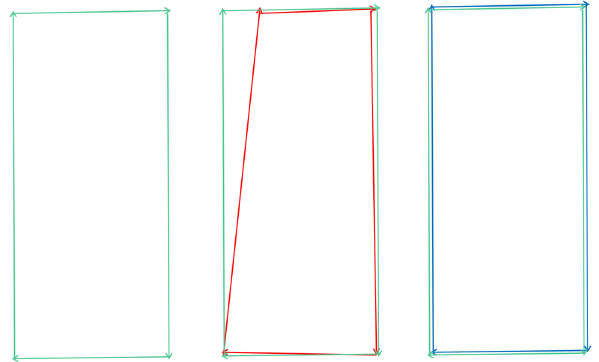
Fig. 1 The green line is the true trajectory. The red line is the drift- ing trajectory. The blue line indicates that the machine is back to true trajectory by LCD Fig. 2 The image is using CNN to detect